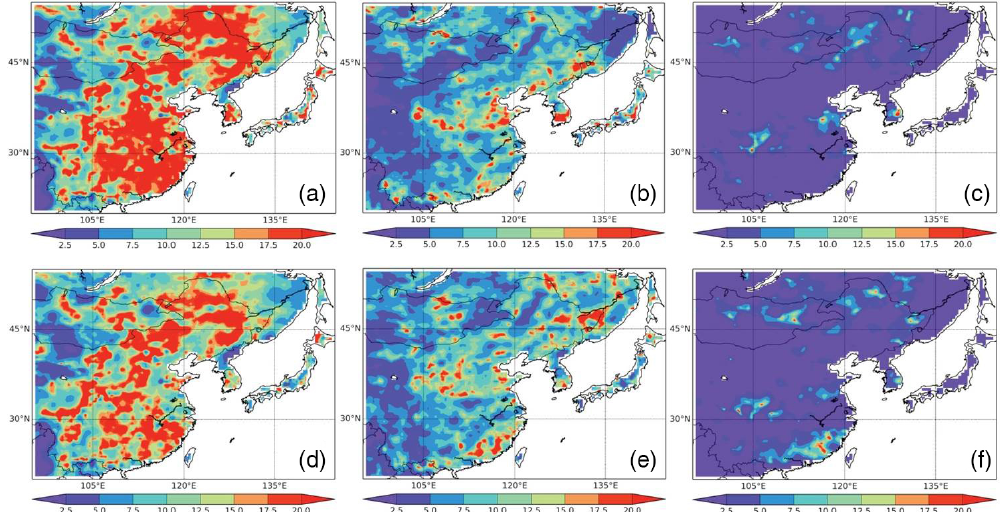
Figure 2. The signal-to-noise ratio (SNR) for the properties shown in Fig. 1, calculated from the corresponding properties of the five precipitation analysis data sets in Table